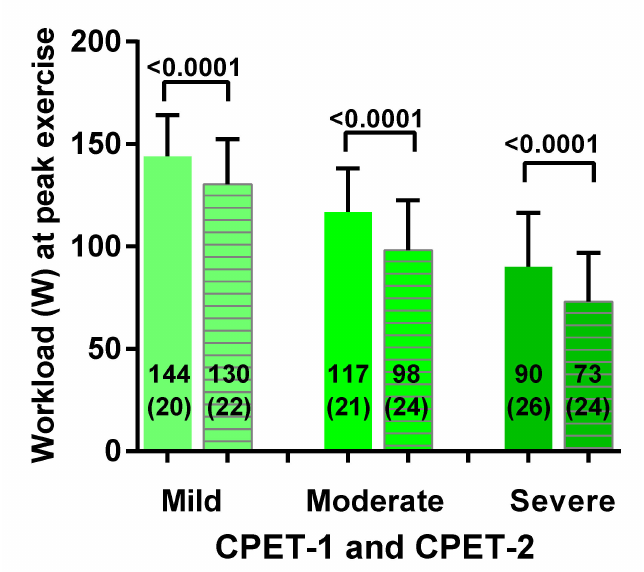
Figure 3. Peak workload for both CPET-1 and CPET-2 for mild, moderate and severe ME / CFS patients. CPET: cardiopulmonary exercise test. For between group comparisons see the result section. CPET-1 is presented by a solid bar and CPET-2 is represented by a lined